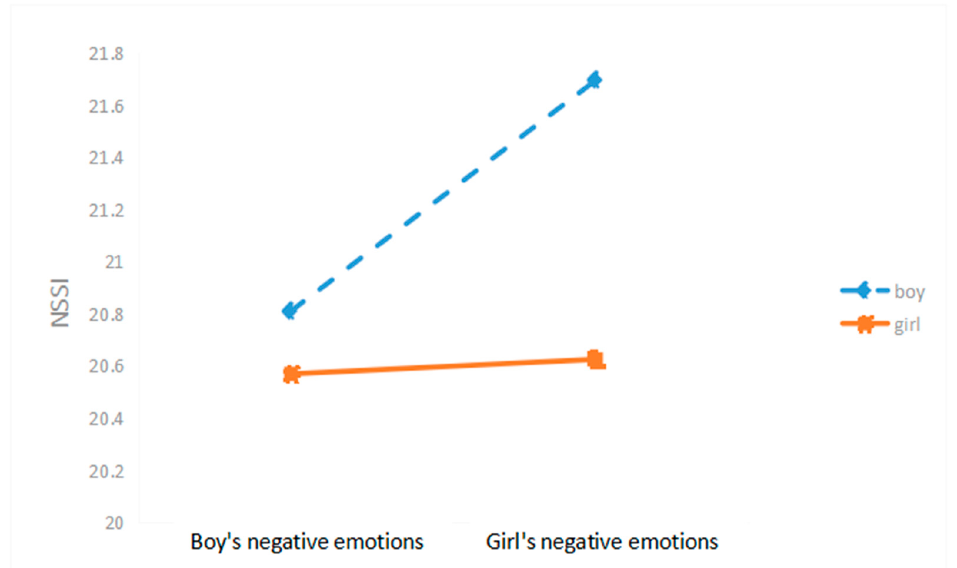
Figure 2. Moderating Role of Gender.